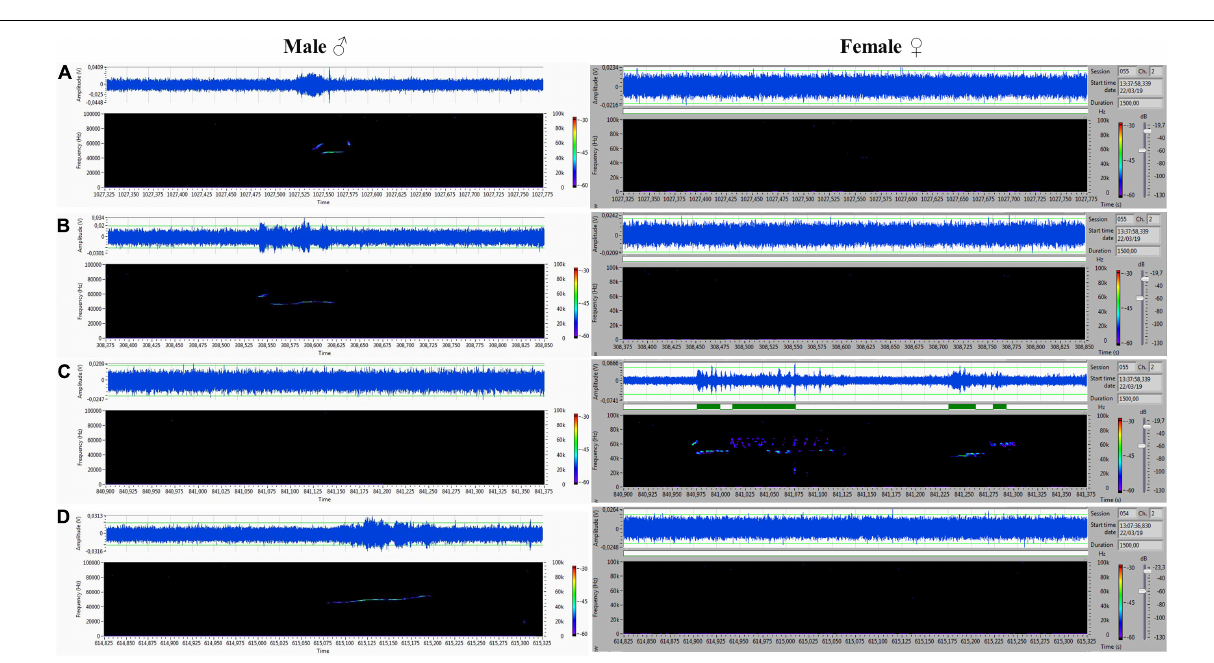
FIGURE 9 | (A–D) Another set of ultrasounds with split type, upward, and step down on the male’s side, and frequency-modulated trills on the female’s